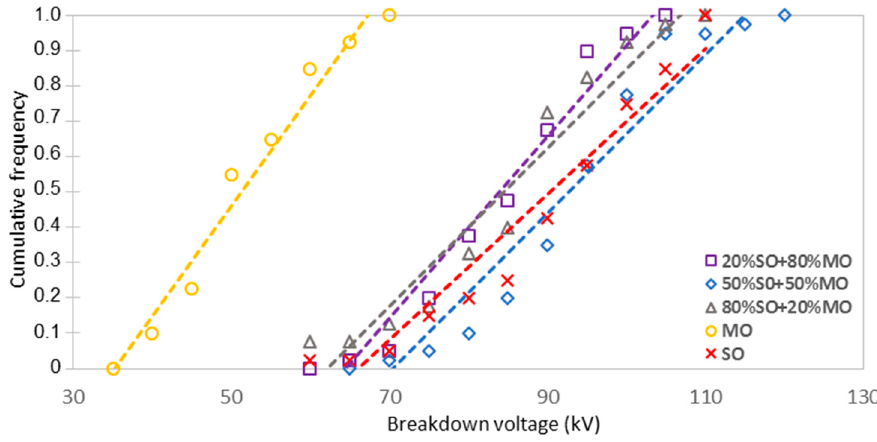
Figure 17. Linear trend of the cumulative frequency of DC breakdown voltage of mineral oil and synthetic ester mixtures.